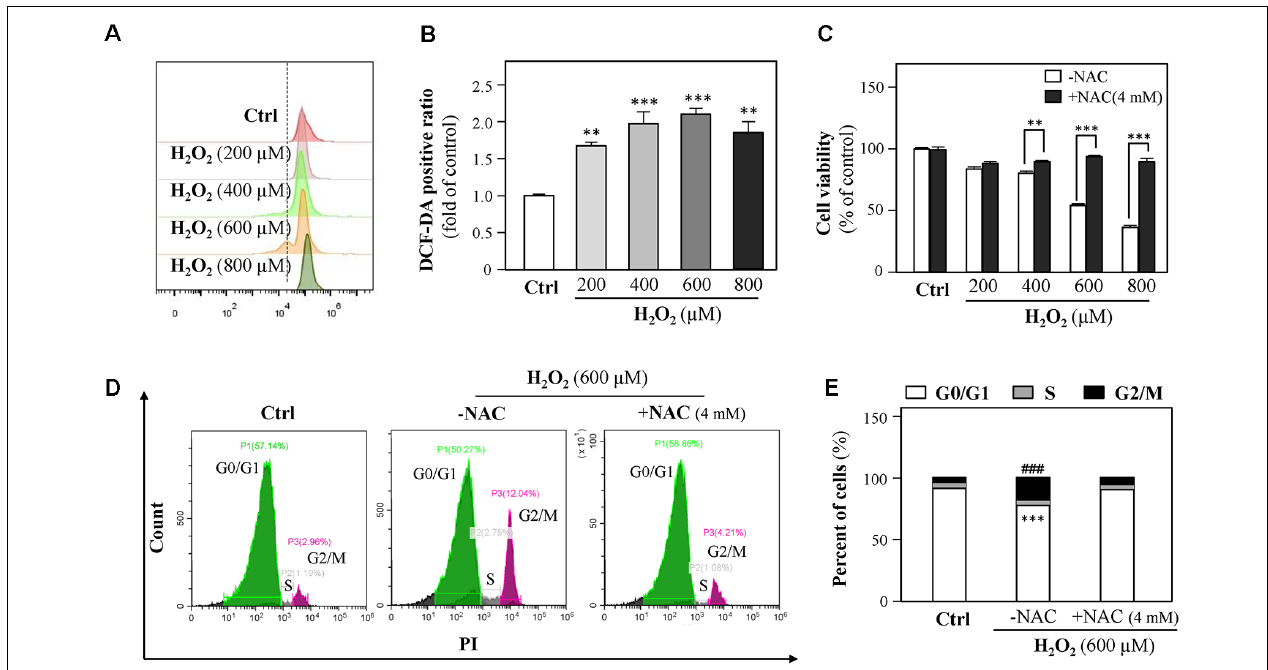
FIGURE 3 | H 2 O 2 increases intracellular reactive oxygen species (ROS) formation, thus causing cell-cycle arrest. (A) Cultured HT-22 cells were incubated with H 2 O 2 at different concentrations (200–800 µ M) for 24 h; the control group consists of the untreated cells. The amount of intracellular ROS was detected by DCFH-DA using a flow cytometry. (B) Mean fluorescence density of ROS level was calibrated from panel (A) . (C) Cultured HT-22 cells were treated with or without NAC (4 mM); simultaneously, the cells were treated with H 2 O 2 at different concentrations (200–800 µ M) for 24 h. The cell viability test was performed using CCK-8 kit, and the changes were shown in histograms as percentage with control. (D) Cultured HT-22 cells were seeded in six-well plates and incubated with H 2 O 2 (600 µ M) in the presence or absence with NAC (4 mM) for 24 h, respectively. The control group consists of the untreated cells. Cell apoptosis was detected by flow cytometry with Annexin V/PI apoptosis detection kit using a flow cytometer. (E) Values are in percentage of apoptotic cell rates of live cells, apoptotic cells, and dead cells, as calibrated from panel (D) . Values are shown in percentage; each point represents the mean ± SEM, n = 3. ∗∗ p < 0.01, ∗∗∗ p < 0.001 and ### p < 0.001 vs. H 2 O 2 -treated group. NAC, N